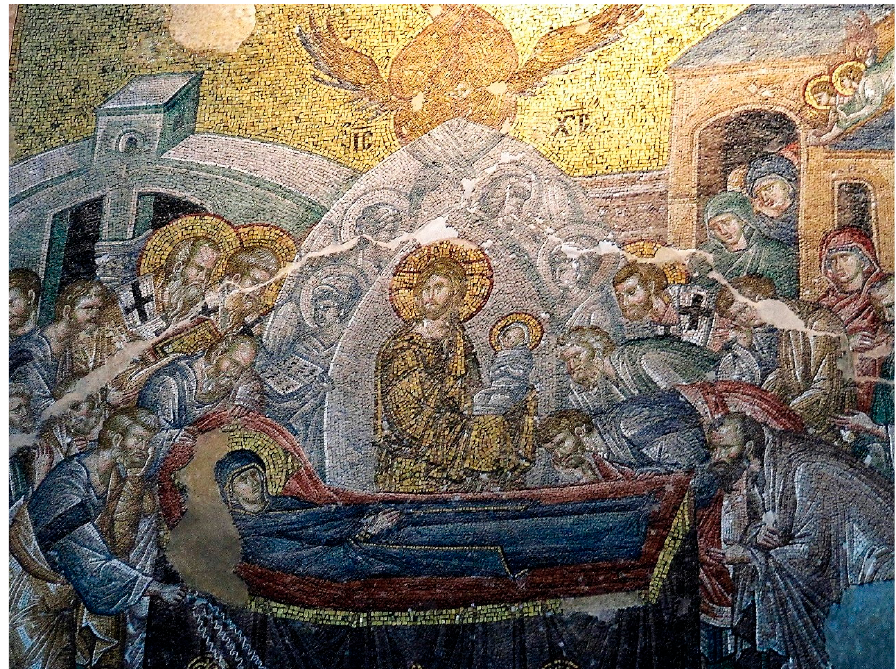
Figure 5. Dormition of the Theotokos , (detail), mosaic, ca. 1315–1321, The Chora Monastery, Istanbul, Turkey. (Photo credit: the author).